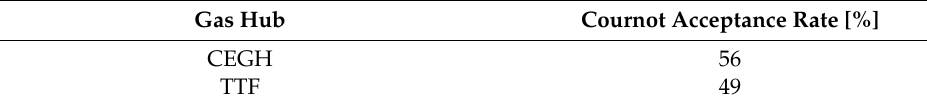
Table 5. Cournot acceptance